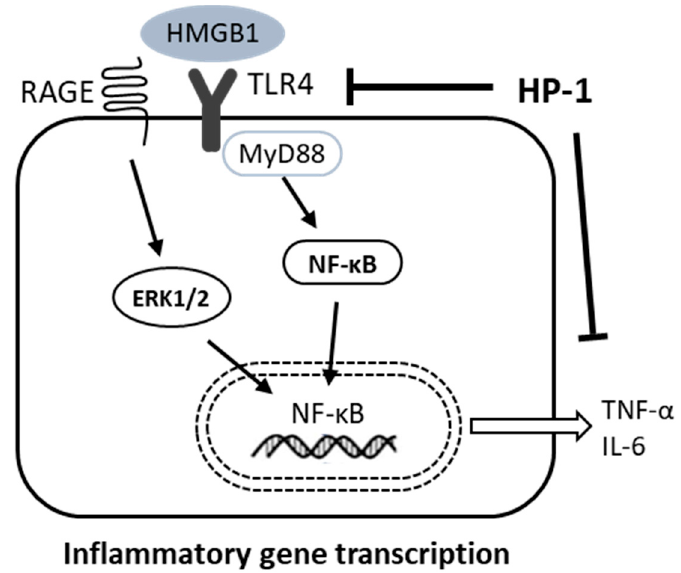
Figure 7. Schematic diagram showing that HP1 inhibits cardiac dysfunction in SHRs through intracellular HMGB1-TLR4-NF κ B signaling suppression. SHR, spontaneously hypertensive rat; HP1, Vitis labrusca leaves extract; HMGB1, high mobility group box 1; TLR4, toll-like receptor 4; MyD88, myeloid differentiation primary response 88; NF κ B, nuclear factor kappa-light-chain-enhancer of activated B cells; TNF- α , tumor necrosis factor alpha; IL-6, interleukin-6; RAGE, receptor for advanced glycation end products; and ERK1/2, extracellular signal-regulated kinases.